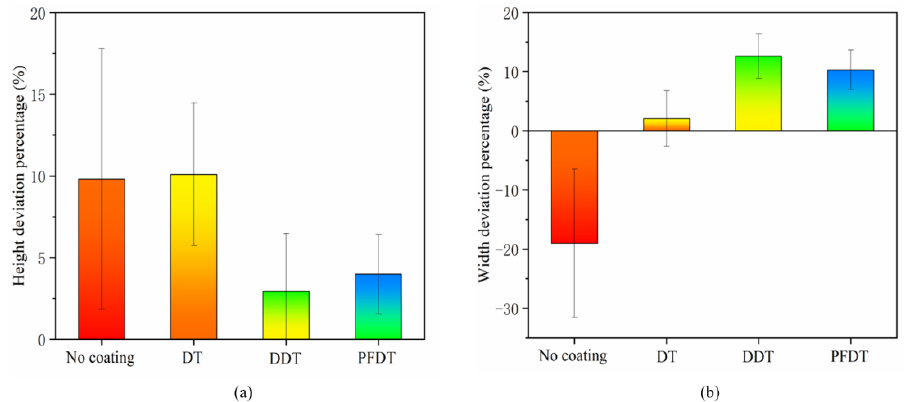
Figure 11. Deviation percentages of the microstructure: ( a ) height; ( b ) width .